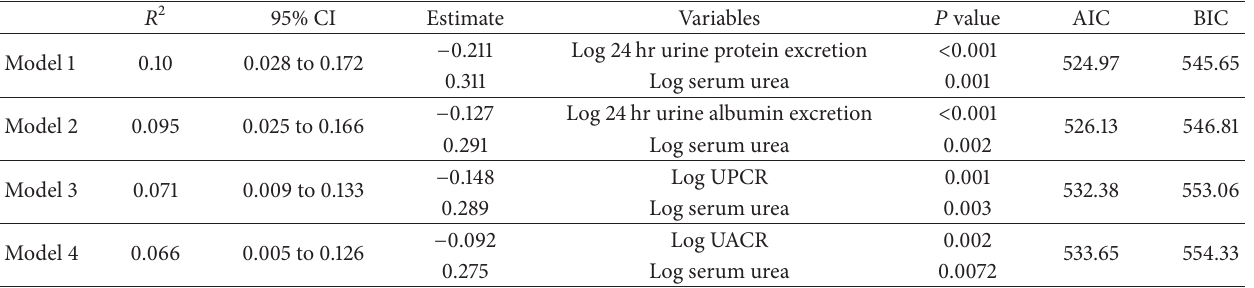
Table 3: Models predicting GFR decline ∗